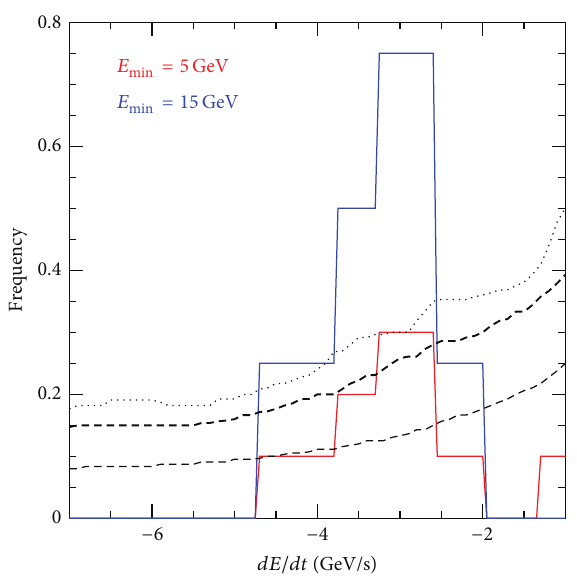
Figure 8: Here shown are the results of a study exactly of the type already described in Figure 7 (including the restriction to the time interval from 190 seconds to 640 seconds after the trigger), but now excluding from the analysis a 5.2 GeV event from about 610 seconds after trigger. Dotted/dashed lines represent again the 10 %, 1 %, and 0.23 % probability that the given frequency of occurrence of spectral lags is a chance occurrence.